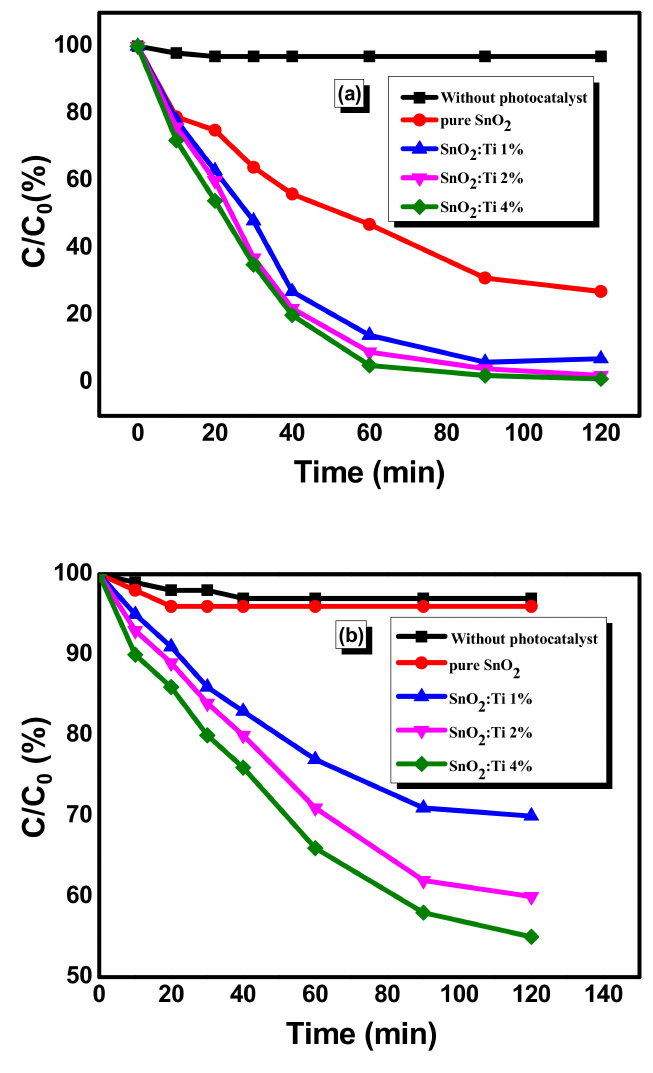
Figure 9. Plots of (C/C 0 ) versus irradiation time (t) for pure and Ti doped SnO 2 nanoparticles under ( a ) UV light and ( b ) visible